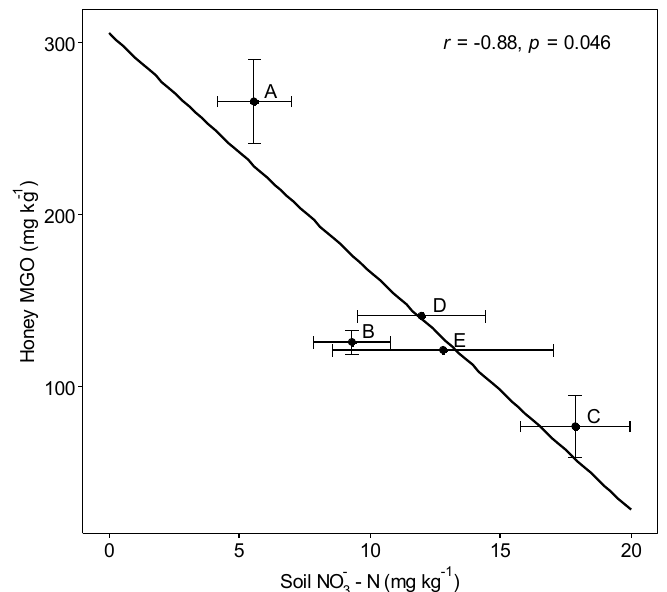
Figure 4. Honey MGO versus soil NO 3 − -N. Values are means for sites A-E (honey n = 1–9, soil n = 5–14). Bars represent the standard error of the mean. The black line is a linear regression line. R is the Pearson’s correlation